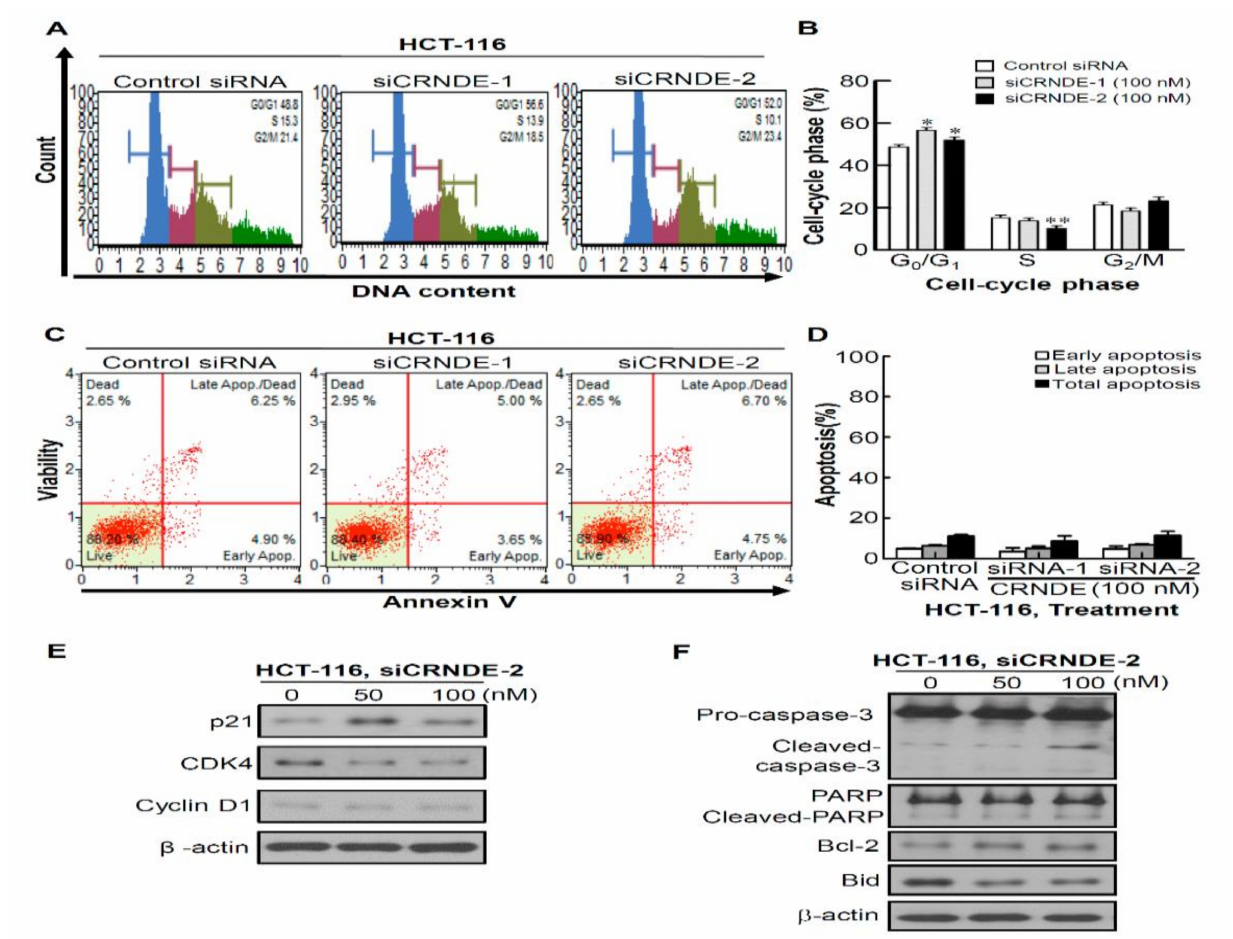
Figure 3. Functional roles of colorectal neoplasia differentially expressed (CRNDE) in regulating colorectal cancer (CRC) cell growth. ( A ) HCT-116 cells were stained with propidium iodide (PI) and analyzed using a Muse™ Cell Analyzer. ( B ) The quantification result of PI-positive cells with CRNDE-knockdown. ( C ) HCT-116 cells were stained with Annexin V-FITC and analyzed using a Muse™ Cell Analyzer. ( D ) Quantification of results of Annexin V-positive cells with CRNDE-knockdown. Knockdown of CRNDE-induced cytotoxicity is mediated by cell cycle regulators ( E ) or apoptotic regulators ( F ). Actin was used as a loading control. * p < 0.05, ** p <